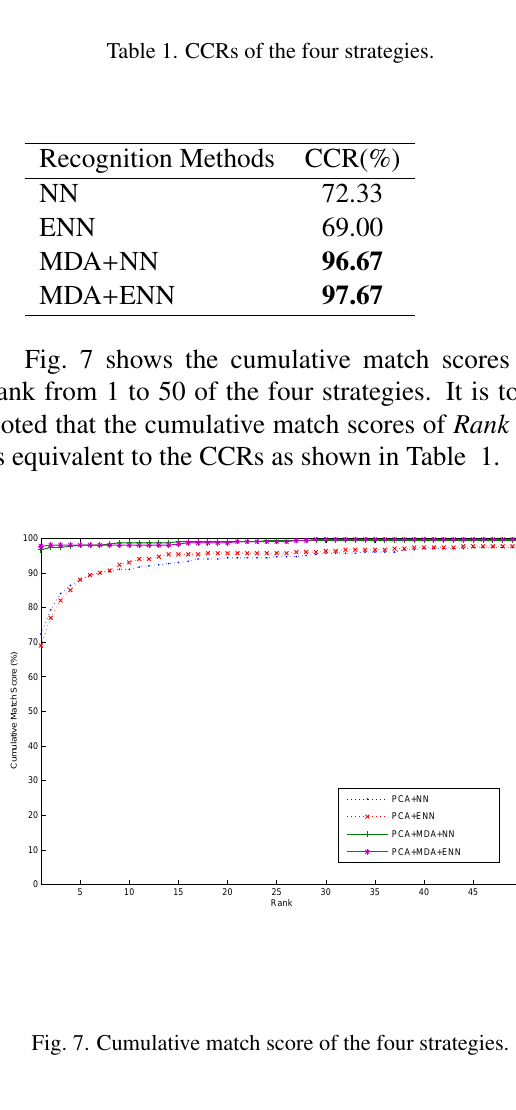
Table 1. CCRs of the four strategies.